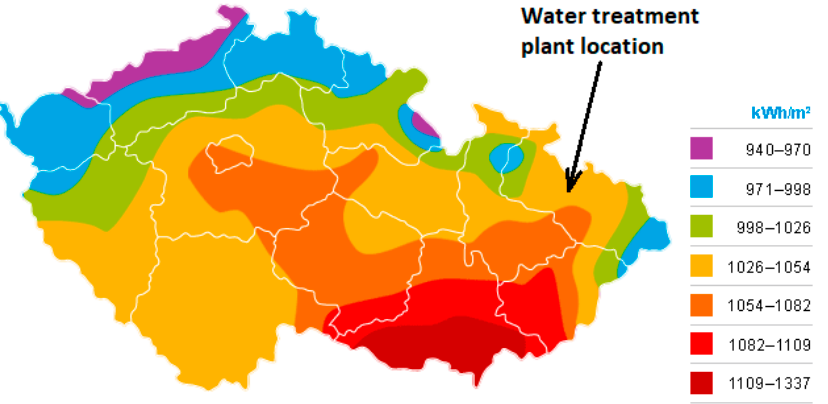
Figure 7. Solar radiation in the Czech Republic.